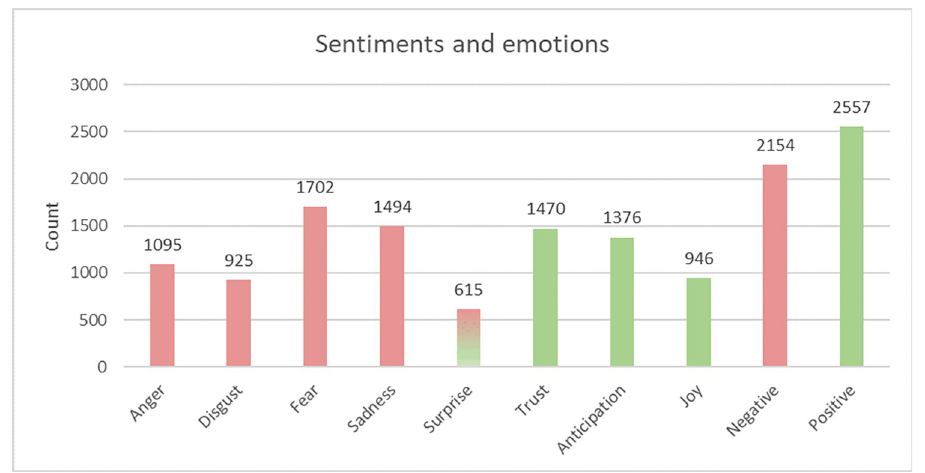
Fig 1. Frequencies of patients’ and caregivers’ sentiments and emotions textually expressed when discussing clinical trials. The negative polarity of emotions and sentiments is indicated in red, and the positive ones–in green. Both red and green were used for emotions that may be associated with both negative or positive emotions and sentiments. The count represents the total frequency of association between the word and one or more emotions and/ or one of two polarities (negative and positive) present in the data body